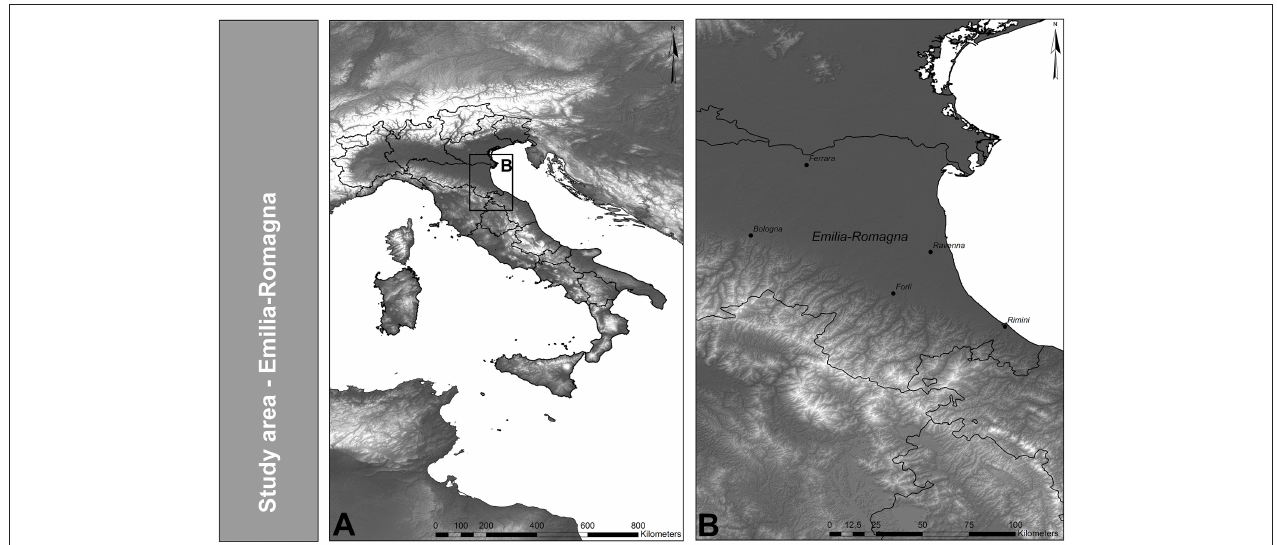
FIGURE 1 | Study area—Emilia-Romagna. (A) Italy (B)